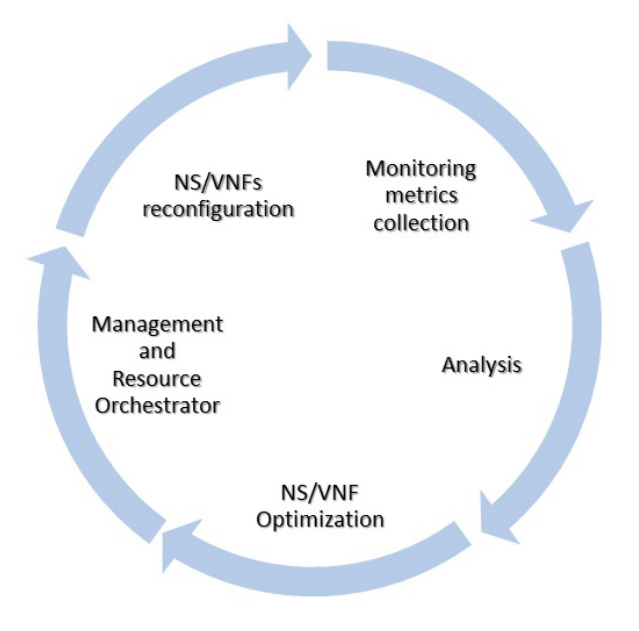
Figure 2. Continuous optimization